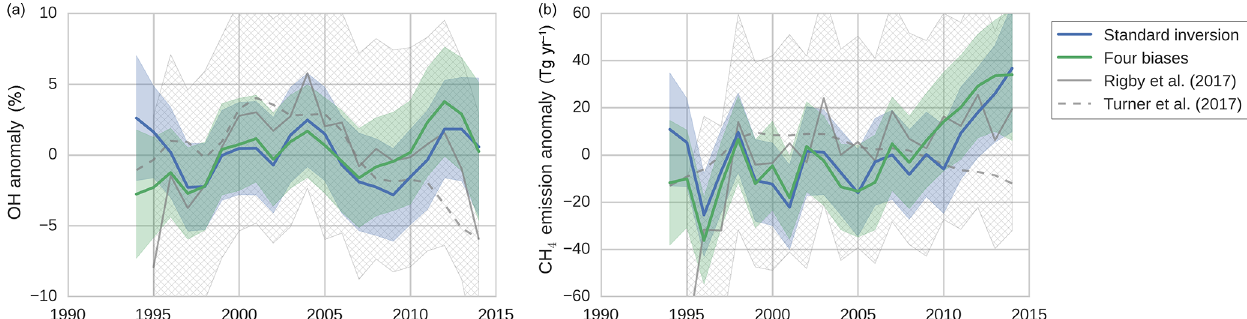
Figure 6. The results of two inversions of the two-box model: tropospheric OH anomalies (a) and CH 4 emission anomalies (b) . In the standard inversion, we kept IH transport, NH / SH OH ratio, and stratospheric loss of MCF constant, and we used NOAA observations. In the second inversion, we implemented all four bias corrections instead (as described in Sect. 2.4). Both the mean anomalies and the 1-standard-deviation envelopes are shown, where anomalies were taken relative to the time-averaged mean in each respective ensemble member. Plotted in grey are the anomalies as derived by Rigby et al. (2017) (from the NOAA dataset) and by Turner et al. (2017) (from a combined NOAA and AGAGE dataset), adjusted so that they, too, average to zero. The 1-standard-deviation envelope from the Rigby et al. (2017) estimate is hatched in grey. Table 3. Five metrics that describe the outcome of the two-box inversions. The two-box inversions listed are the standard set-up, four inversions with one bias implemented, and one inversion with all biases implemented. From left to right: (1) mean absolute error (MAE) in OH anomalies between the standard inversion and each respective inversion, (2) trend in OH over the 1994–2015 period, (3) mean lifetime of MCF with respect to OH (tropospheric burden MCF divided by total loss to OH), (4) mean total tropospheric lifetime of CH 4 (tropospheric burden CH 4 divided by total loss CH 4 ), and (5) mean annual CH 4 emissions (with soil sink). Implemented bias(es) MAE OH OH trend τ OH MCF τ trop CH 4 CH 4 emissions (%) (%yr − 1 ) None (standard run) – − 0 . 02 ± 0 . 15 Interhemispheric transport Surface